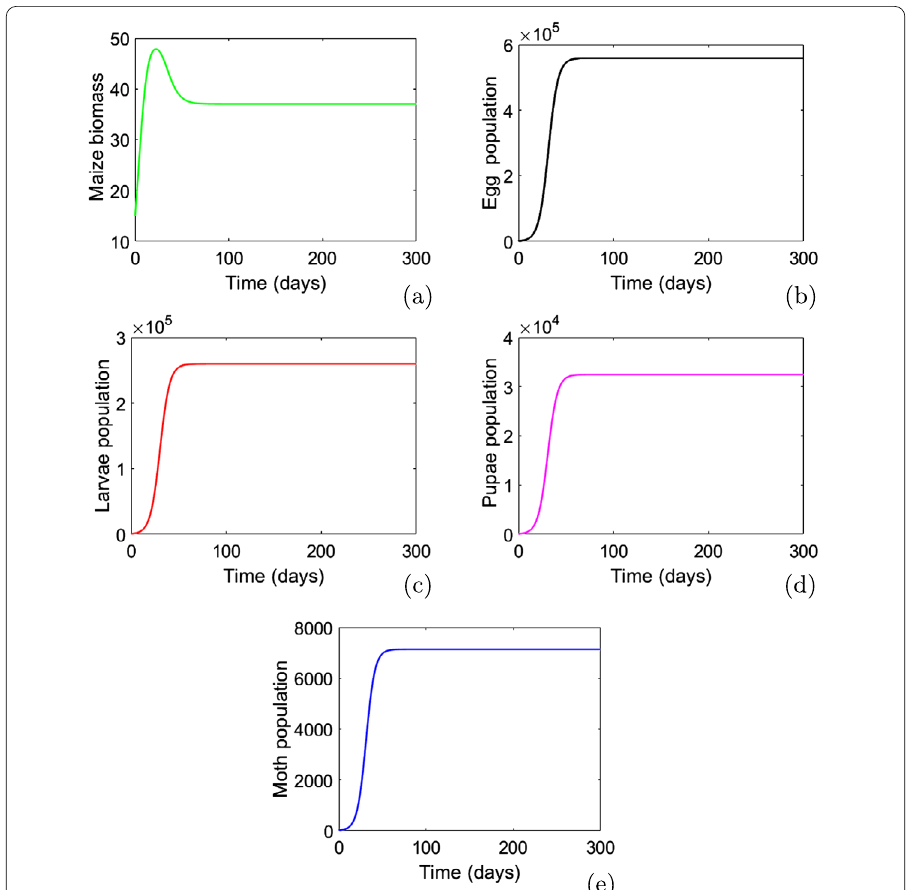
Figure 6 Model solutions showing the effects of a FAW outbreak with a small initial pest life cycle population. We considered E (0) = 100, L (0) = P (0) = 0, and A (0) = 50. Furthermore, we fixed q = 0.8 and u E = u L = u P = u A = 0.45 to obtain R 0 =